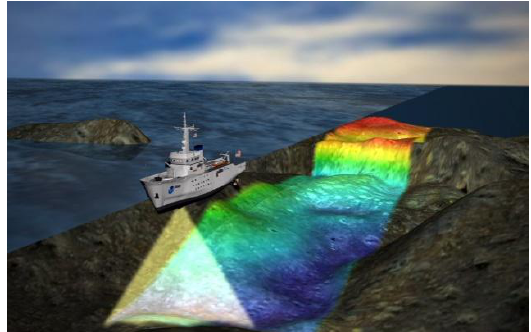
Figure 2 : Multibeam Sonar (© NOAA).